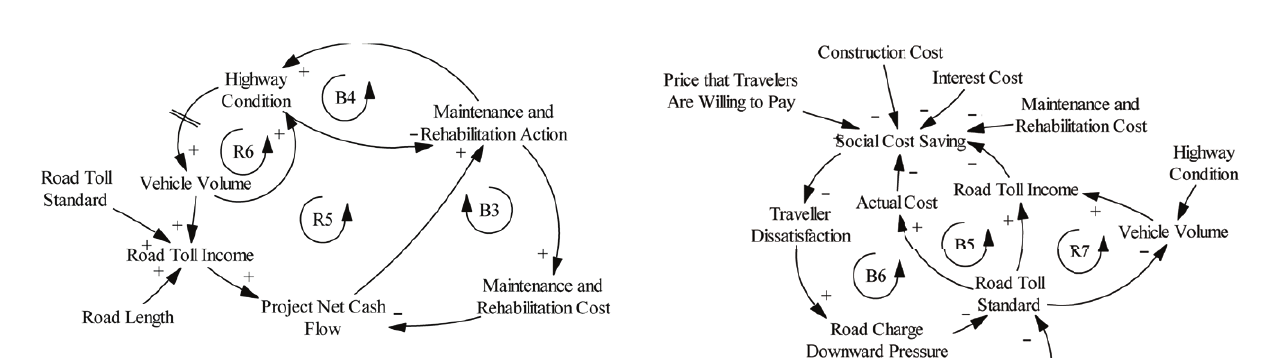
Figure 3. Causal loop diagram for asset management sector